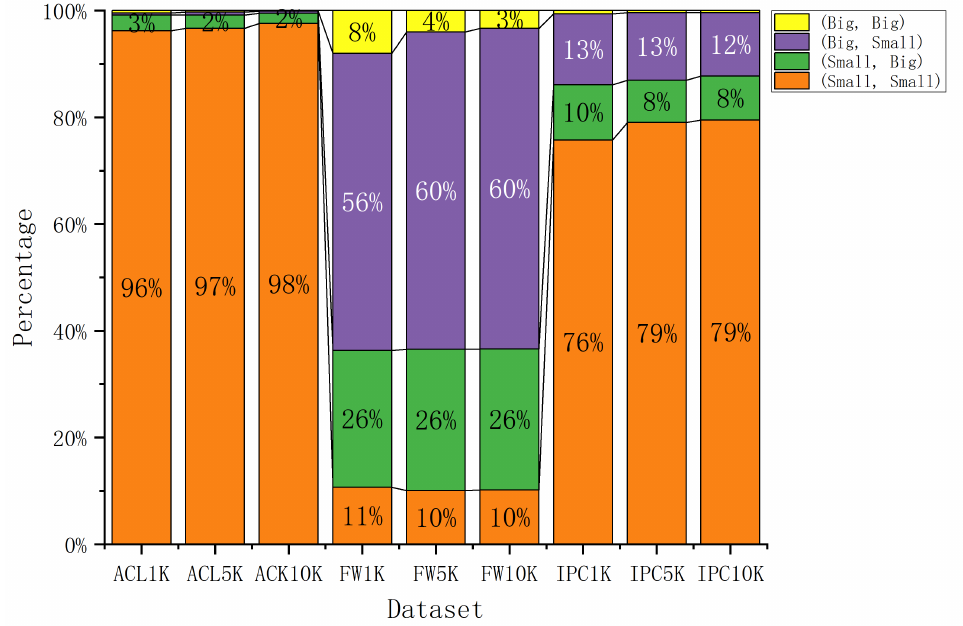
Figure 4. The distributions of the field type vectors in different rulesets. Table 1. Average overlap number of different types of rules. Two-Small